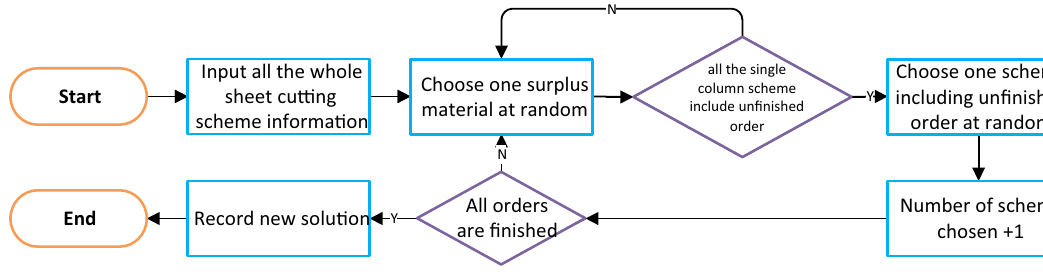
Figure 18. Flowchart of initialization function of genetic algorithm.